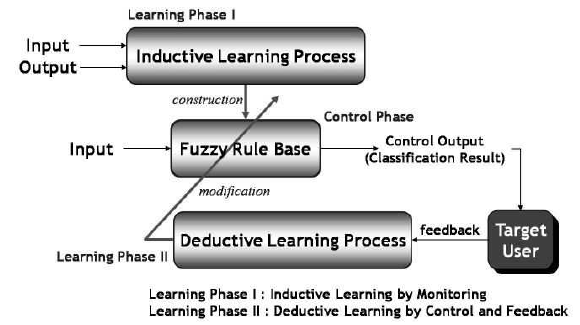
Fig. 16. Structure of fuzzy life-long learning system for human-in-the-loop